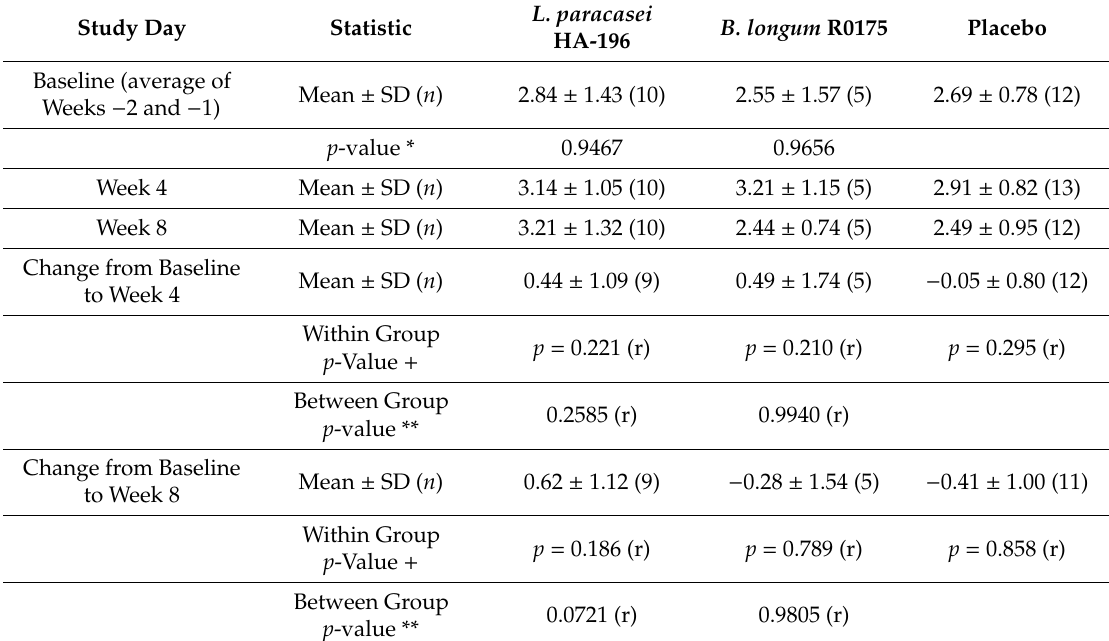
Table 3. Stool consistency at baseline, week 4, and week 8 and change in stool consistency from baseline to week 4, and week for participants with IBS-C in the PP